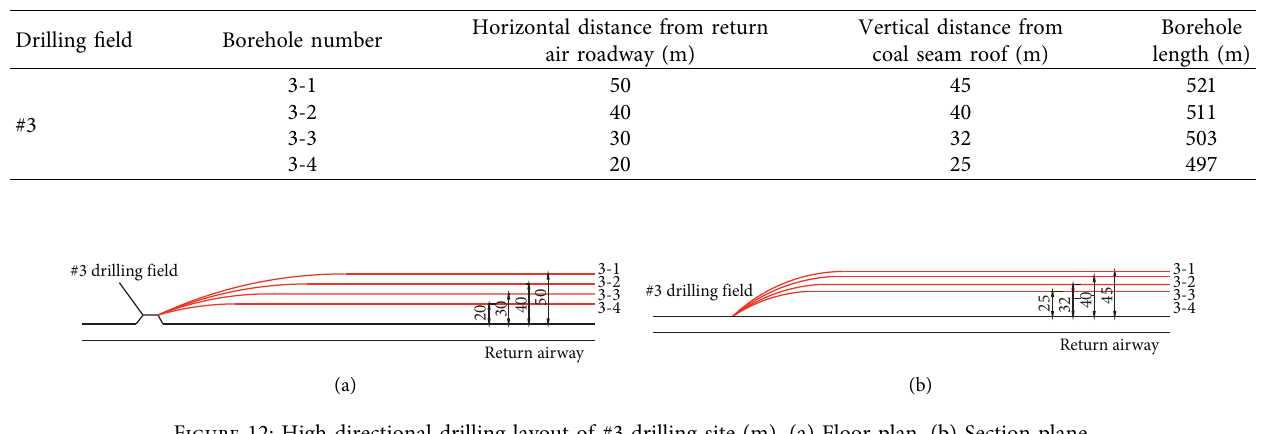
Figure 11: Design trajectory of high directional “parabola” drilling in #1 drilling field (m). (a) Floor plan. (b) Section plane. Table 5: Parameter of high level drilling arrangement.